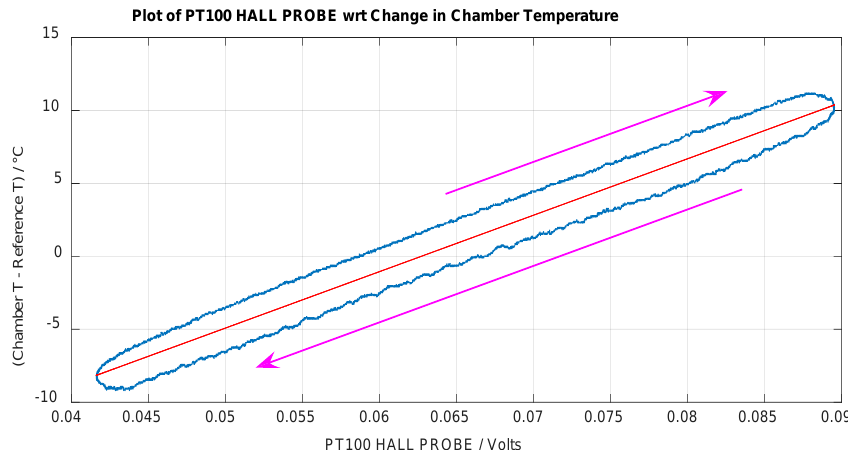
Figure 7. Graph showing the response of the PT100 output voltage to a two cycle temperature sweep from 14 °C to 34 °C. The response is modelled using the red linear plot. Hysteresis direction is shown by the purple arrows.